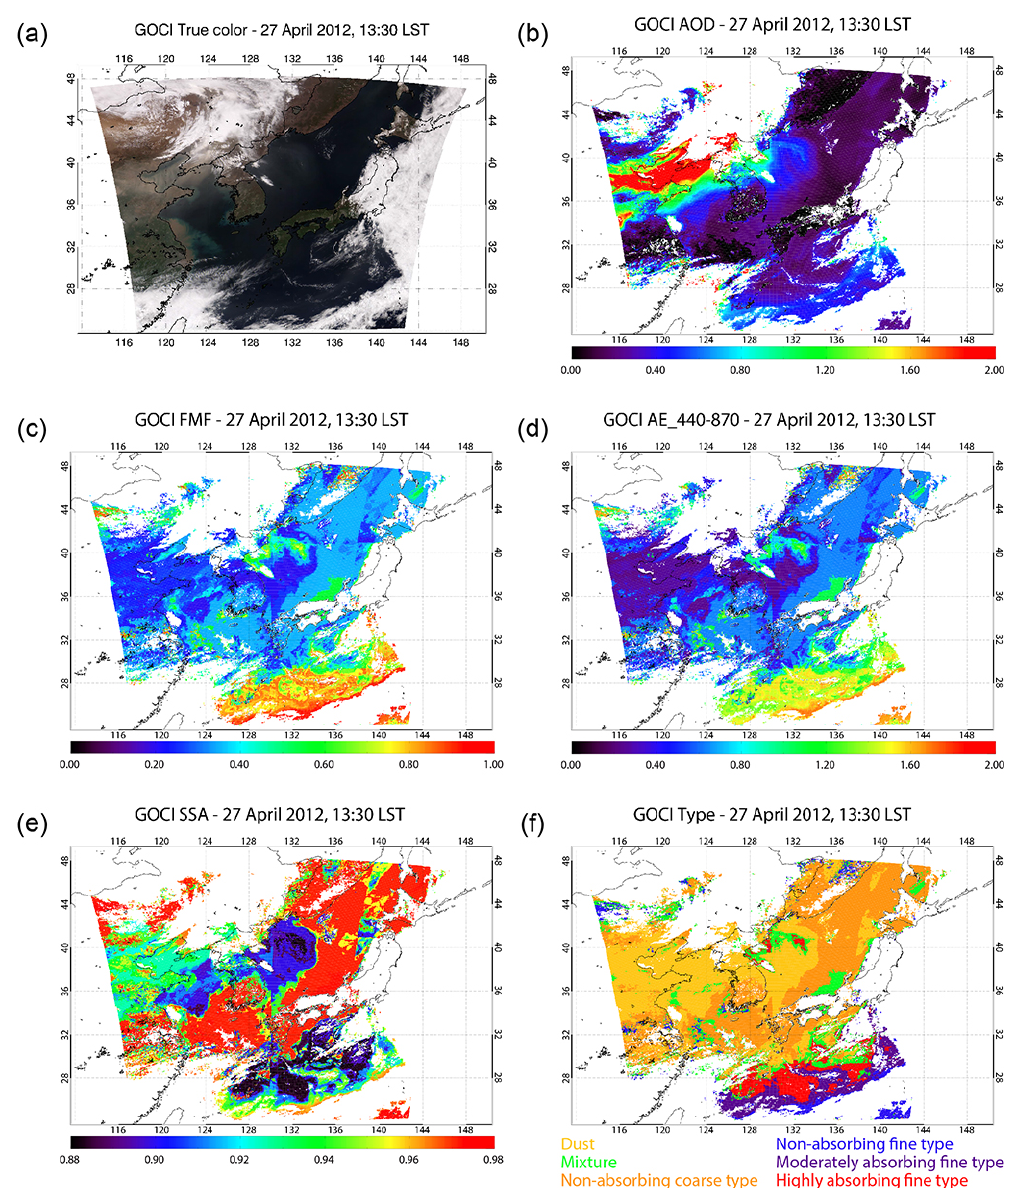
Figure 7. As Fig. 6 except for 27 April